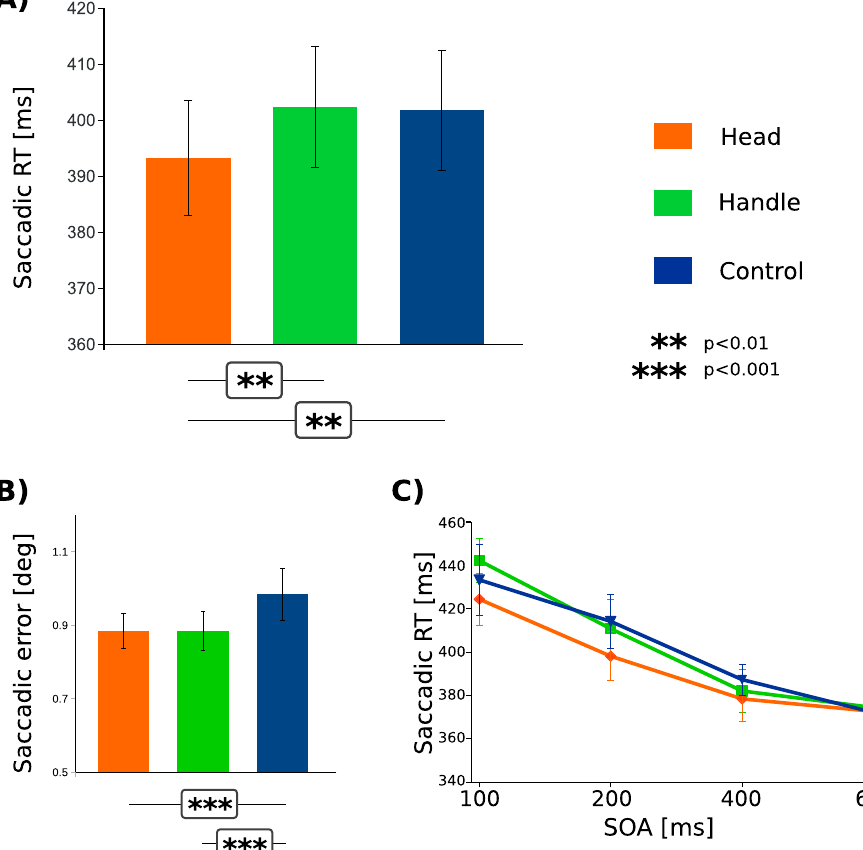
Figure 2. ( A ) Saccadic reaction times across conditions where saccades were congruent with the head (orange), the handle (green) and for control items (blue). Saccades executed towards the side congruent with head had significantly shorter latencies than those towards handle and control items. ( B ) There was no difference in the size of saccadic errors across both main experimental conditions (“Head” and “Handle). Both main conditions yielded saccades significantly more precise than in control condition. ( C ) Saccadic latencies for the main conditions plotted separately across all four SOAs. All error bars represent SEM. Figure created with Inkscape 0.92